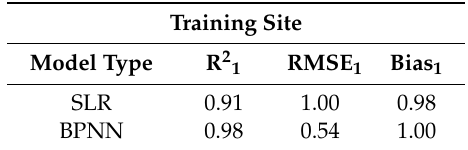
Table 6. Accuracy evaluation of di ff erent models at the training